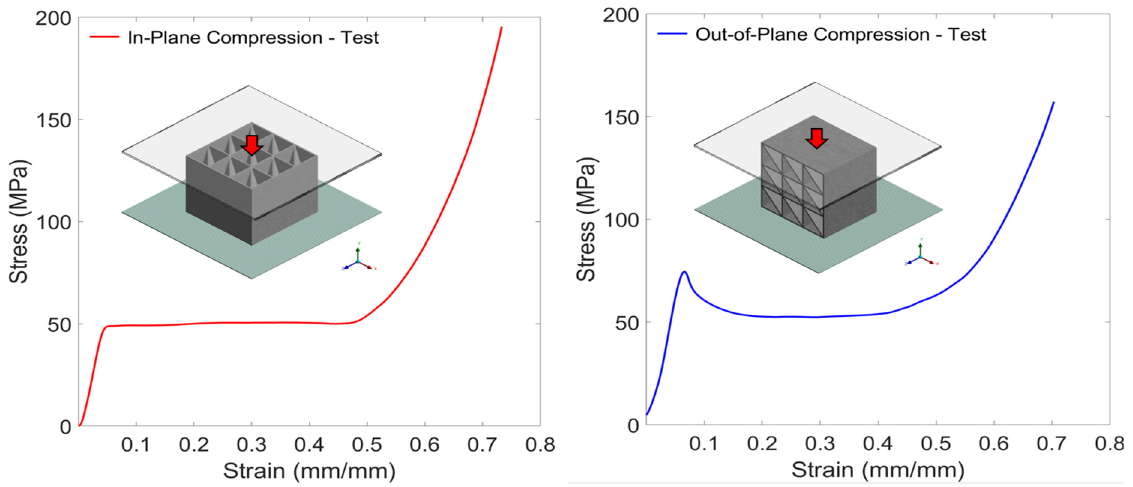
Figure 6. Experimentally determined stress-strain curves under axial ( left ) and lateral ( right ) loading conditions.